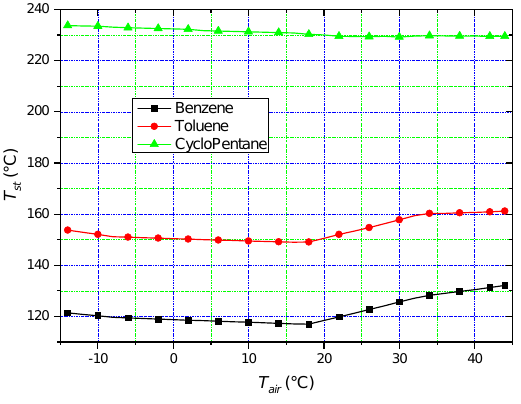
Figure 7. Stack temperature of exhaust gas varying ambient